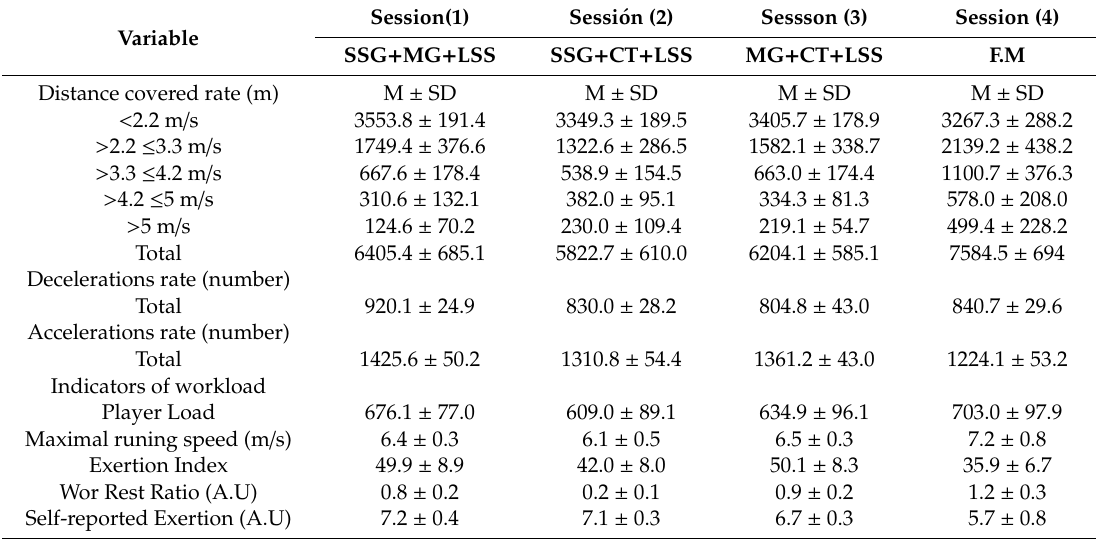
Table 2. The descriptive results for each variable according to task training sessions (TS) and friendly matches (FM) are presented in Table 2. Data are mean ± SD for 14